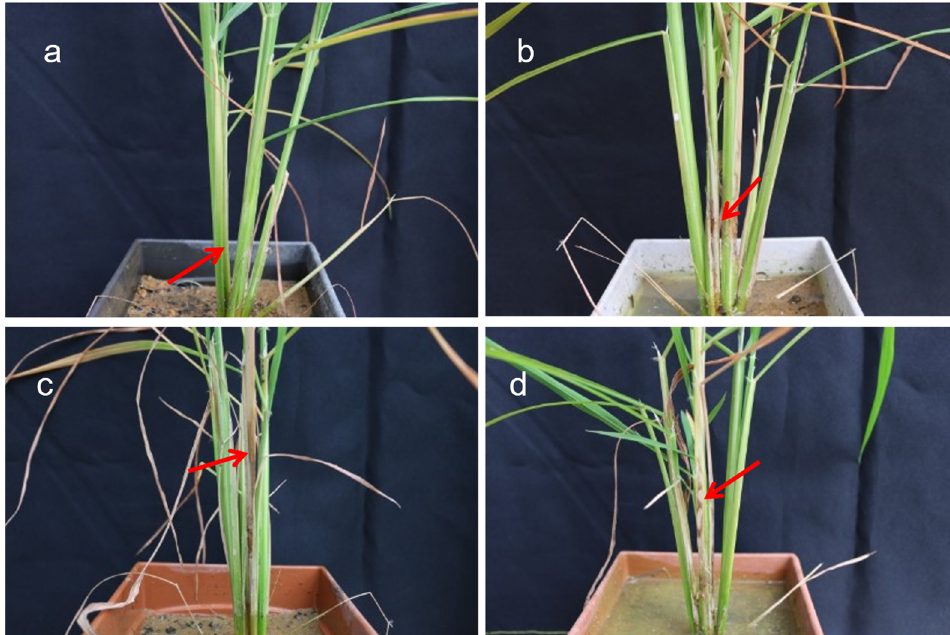
Figure 1. Disease manifestations in different treatments: ( a ) T. asperellum SL2-inoculated rice plants grown under SRI condition exhibited the lowest lesion length compared to ( b ) T. asperellum SL2-inoculated plants grown under conventional condition, ( c ) rice plants without T. asperellum SL2 inoculation grown under SRI condition, and ( d ) rice plants without T. asperellum SL2 inoculation grown under conventional condition.